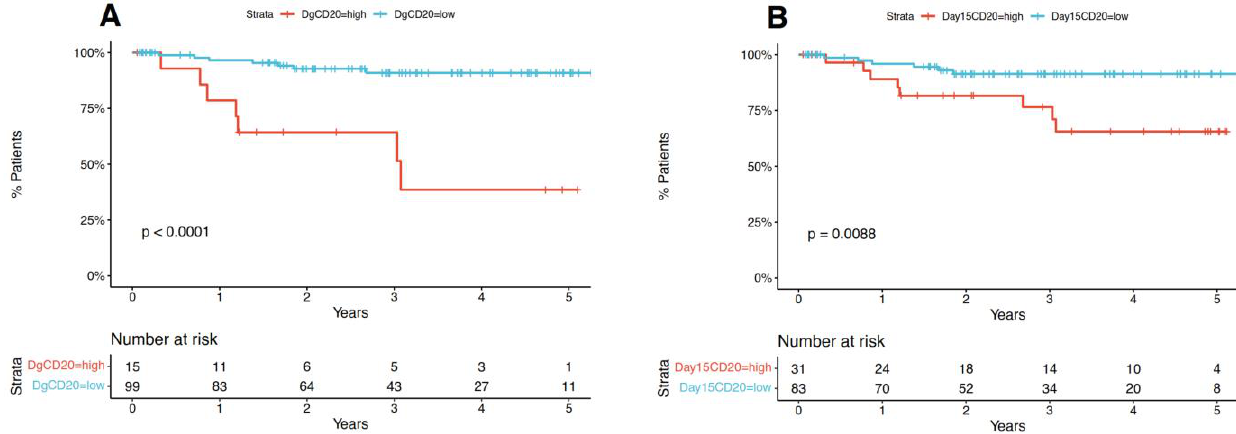
Figure 2. MFI CD20 diagnosis, day 15 and delta CD20 impact on RFS. ( A , B ) Survival was represented in the form of Kaplan-Meier plots and an accompanying table showing the number of patients at risk.